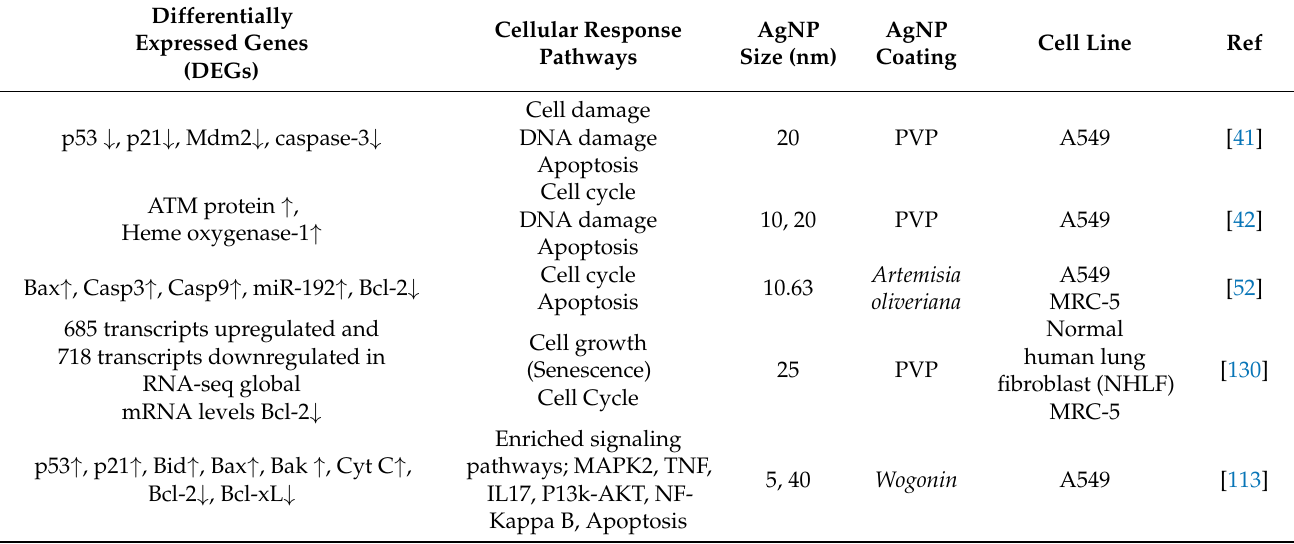
Table 4. Differential expression of genes in lung cell